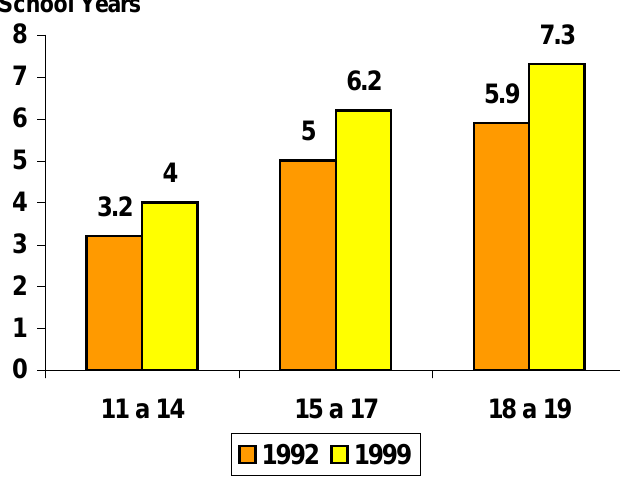
FIGURE 3. Average school years of 10-year-old and higher or older people by age groups. Brazil – 1992/1999. Source: 2000 Summary of Social Indicators. IBGE,